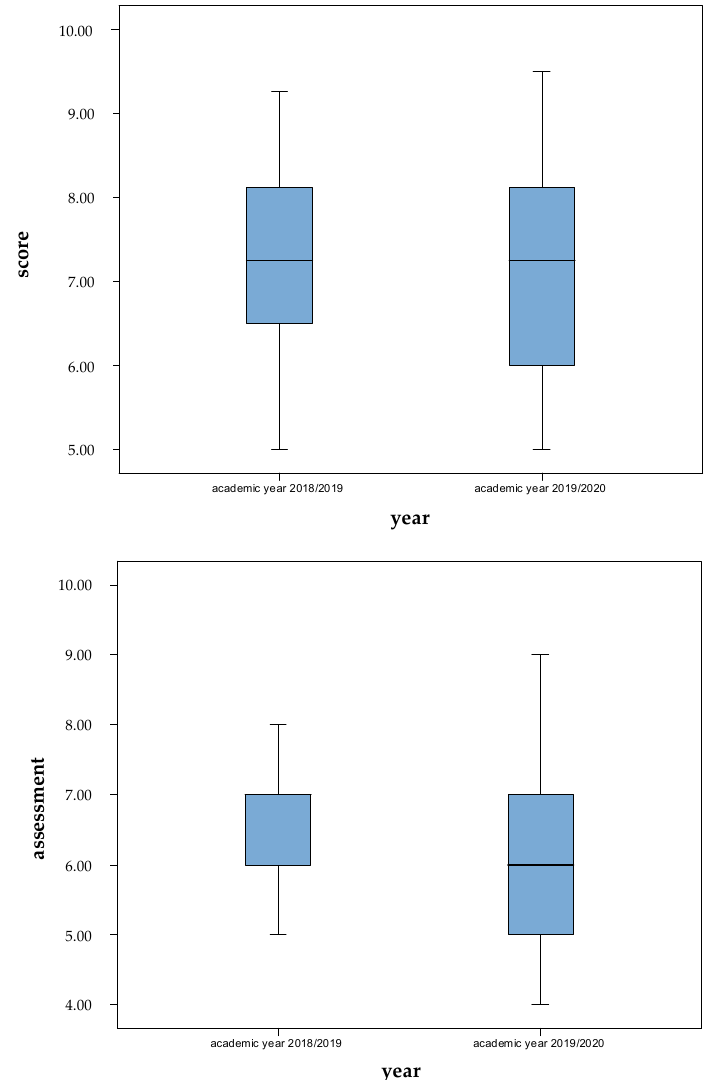
Figure 1. Box plots of score and assessment in function of academic year.